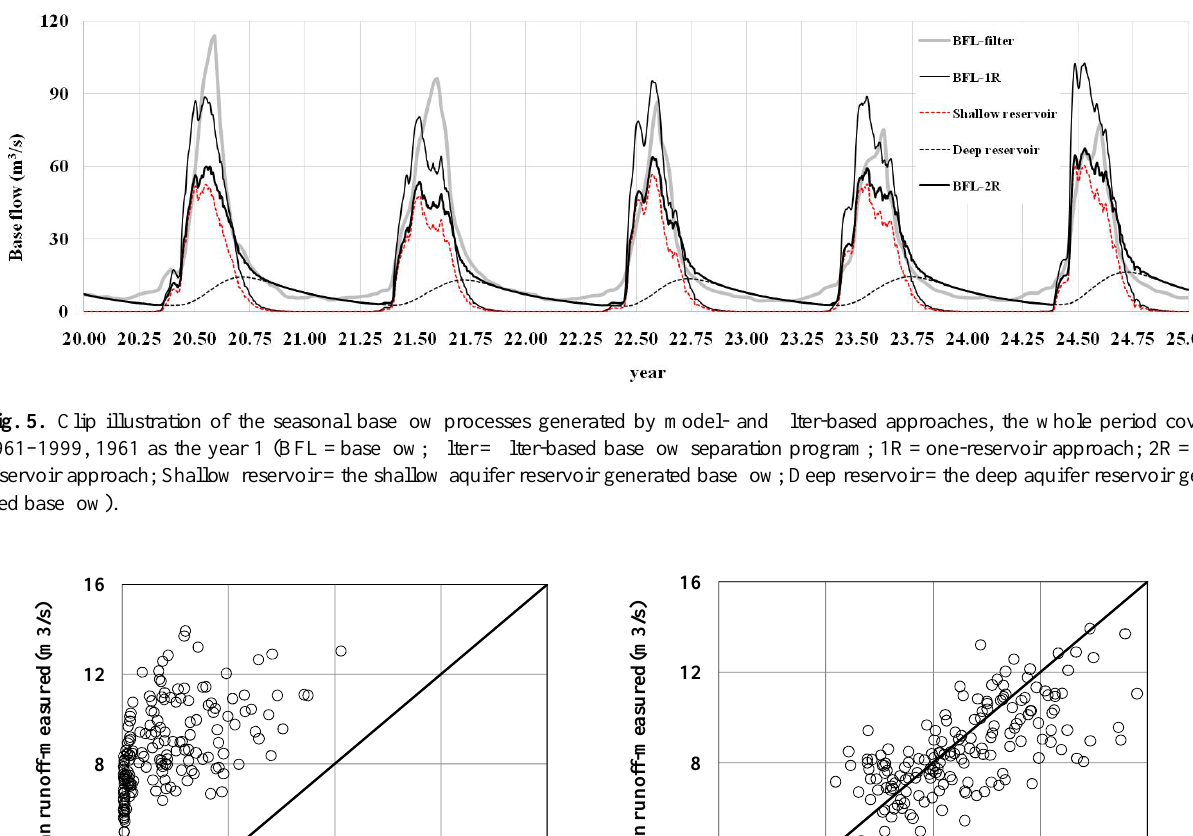
Fig. 6 Comparison of the simulated and measured monthly averaged low-flow discharge rates. (a), the one-reservoir approach was used; (b), the two-reservoir approach was used.